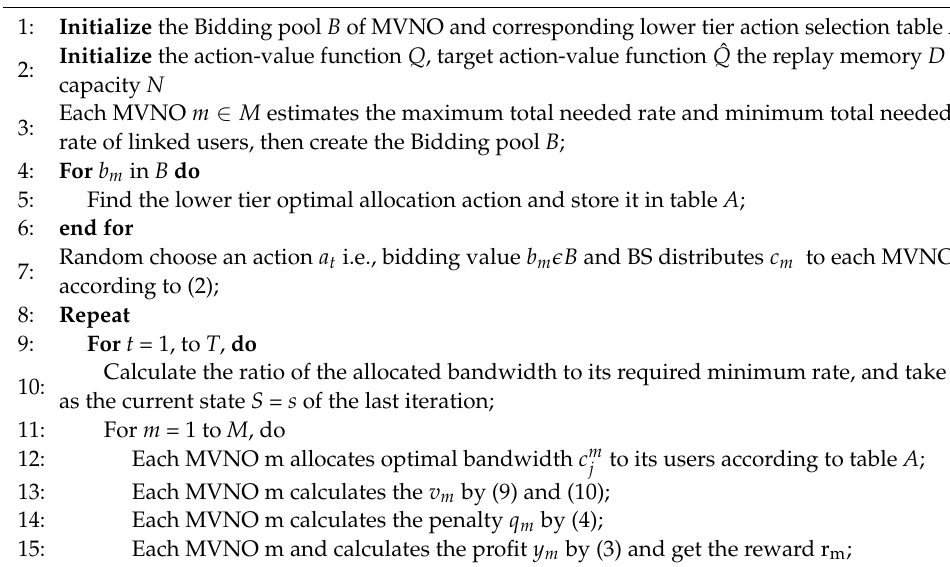
Algorithm 1 DQN and Joint Bidding Algorithm for Upper Tier Bandwidth